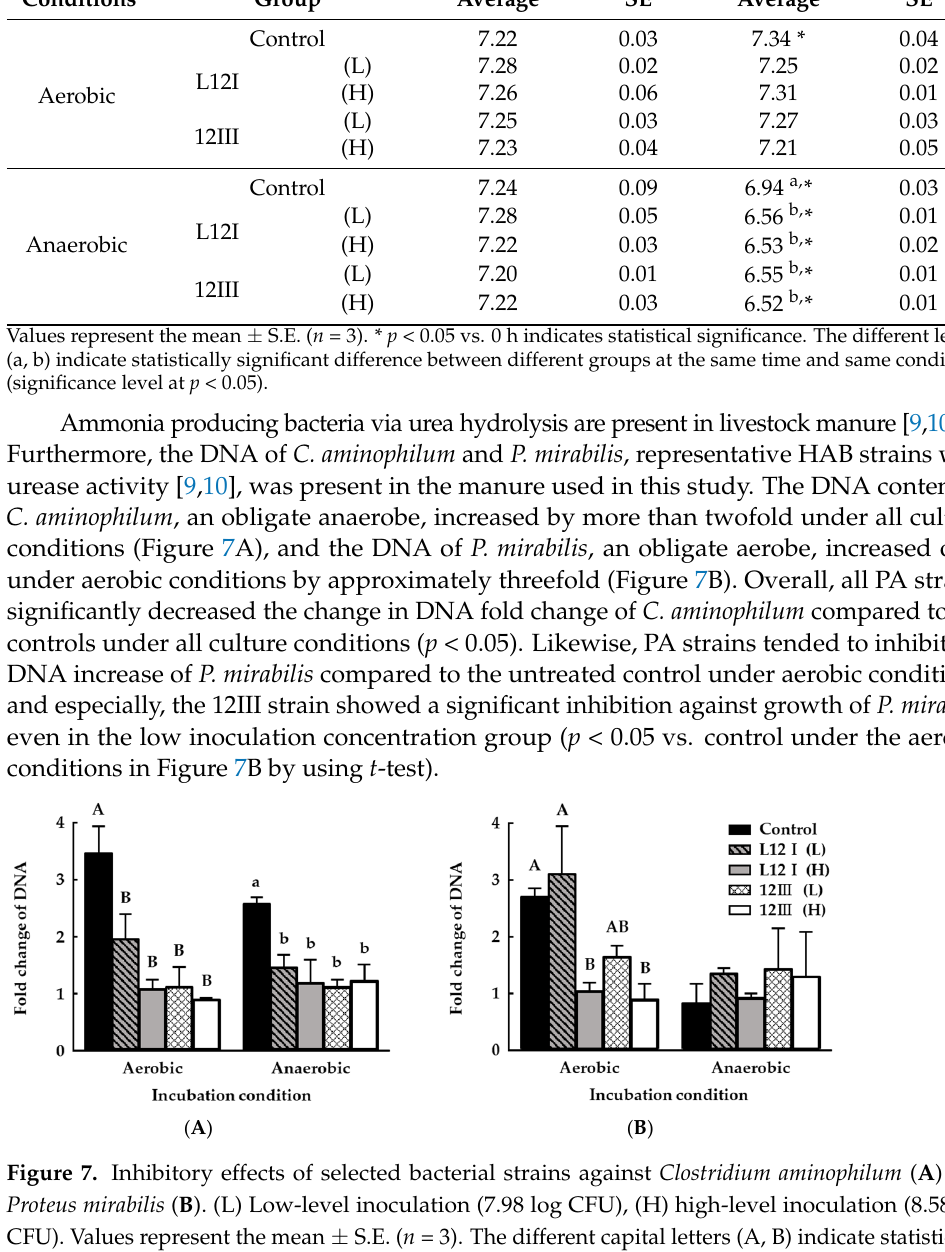
Table 3. Change of pH in manure by using selected bacterial strains in aerobic and anaerobic conditions. (L) Low-level inoculation (7.98 log CFU), (H) high-level inoculation (8.58 log CFU).